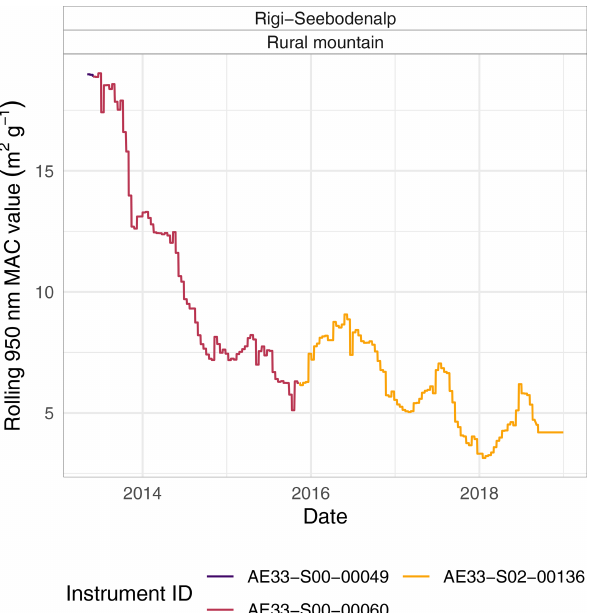
Figure A3. Mass absorption cross-section (MAC) coefficient values for 950nm at Rigi-Seebodenalp coloured by the aethalometers which were operating at the monitoring